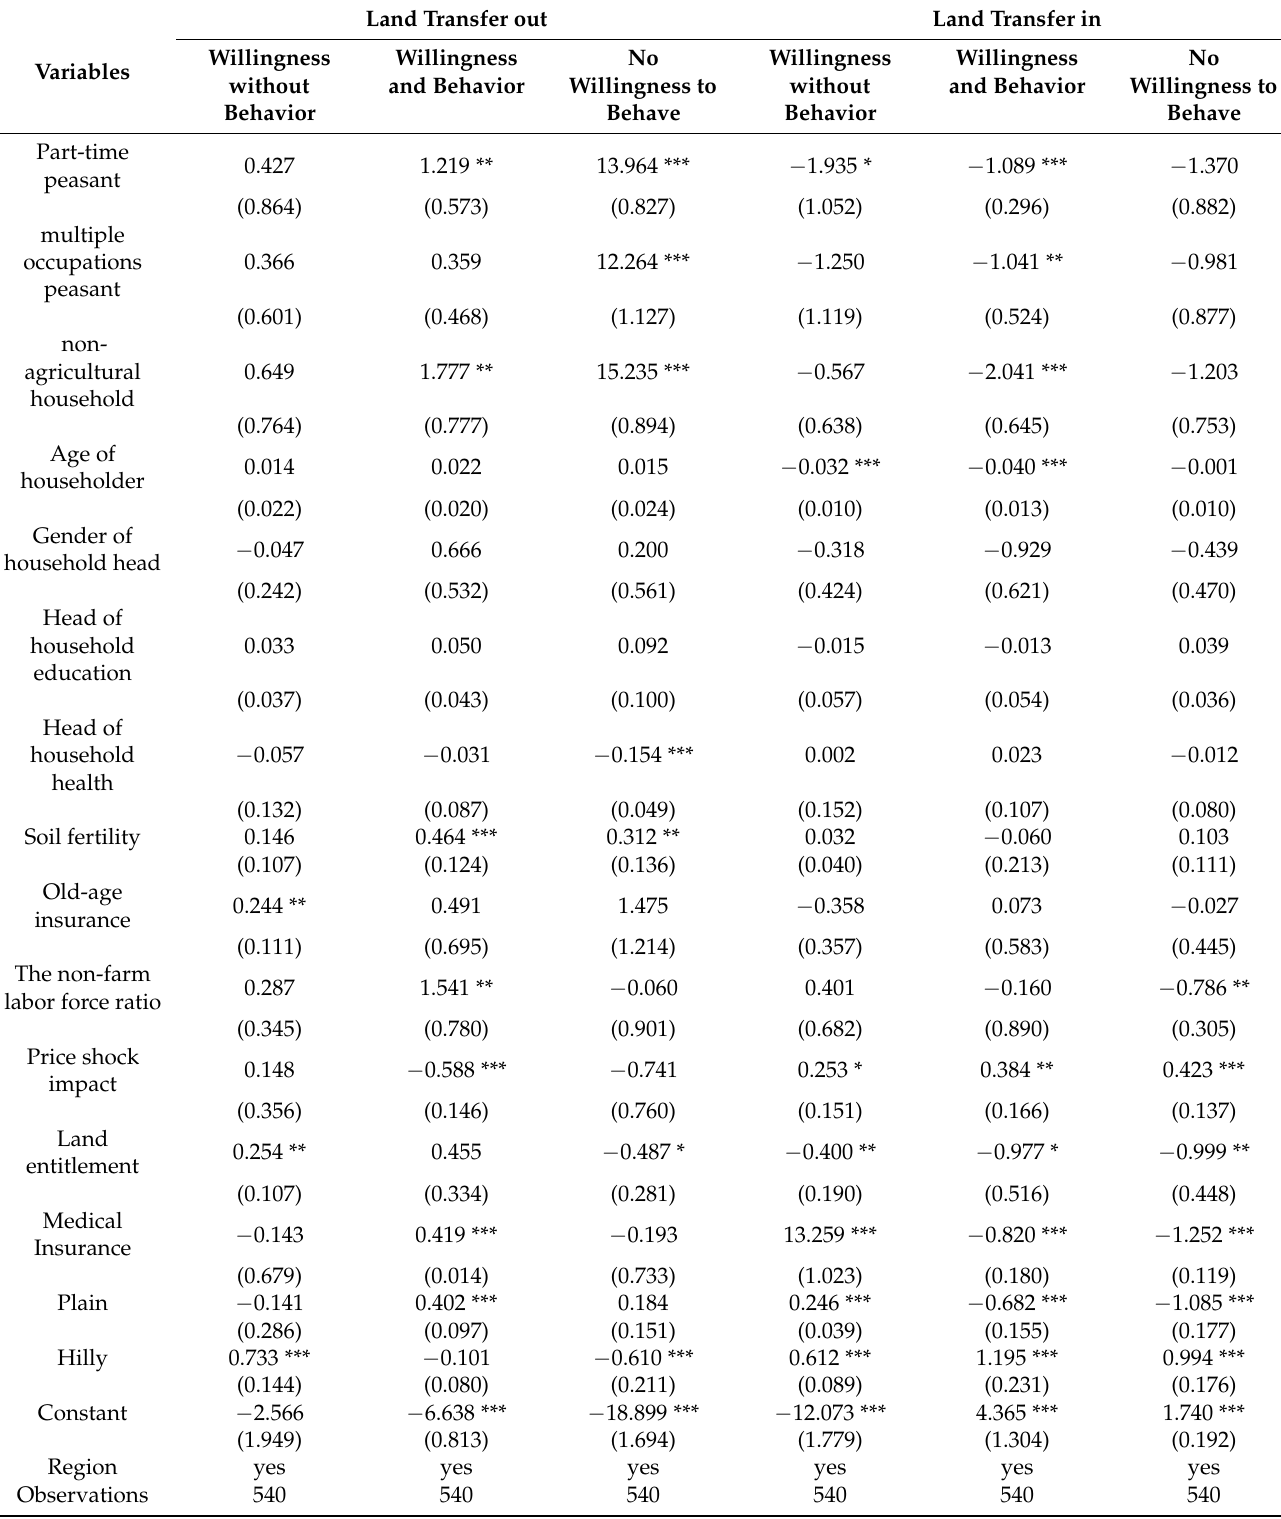
Table 3. Estimated results of the transformation of farm household differentiation on the behavior of willingness to transfer